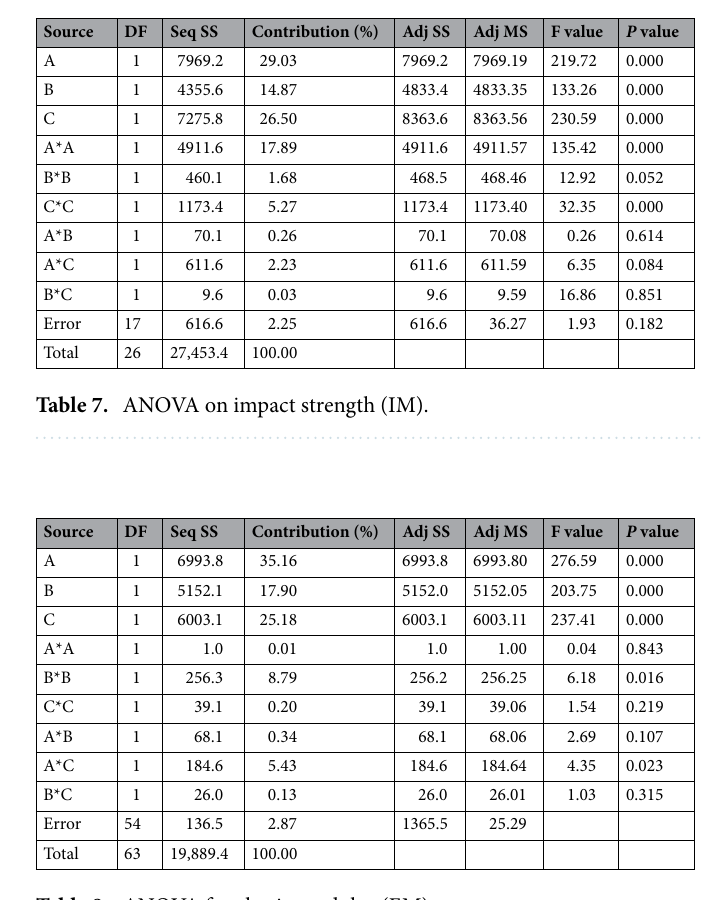
Table 8. ANOVA for elastic modulus